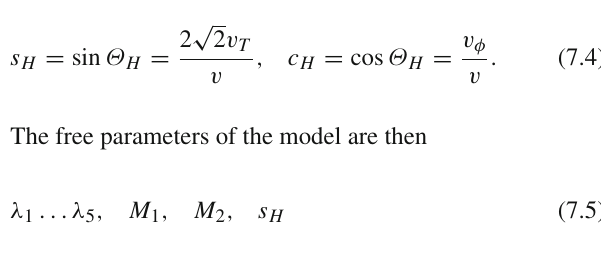
Fig. 9 The size of the one- and two-loop corrections of the lightest scalar mass as a function of the scale Q in at which the input masses of Eq. (6.16) are translated into quartic